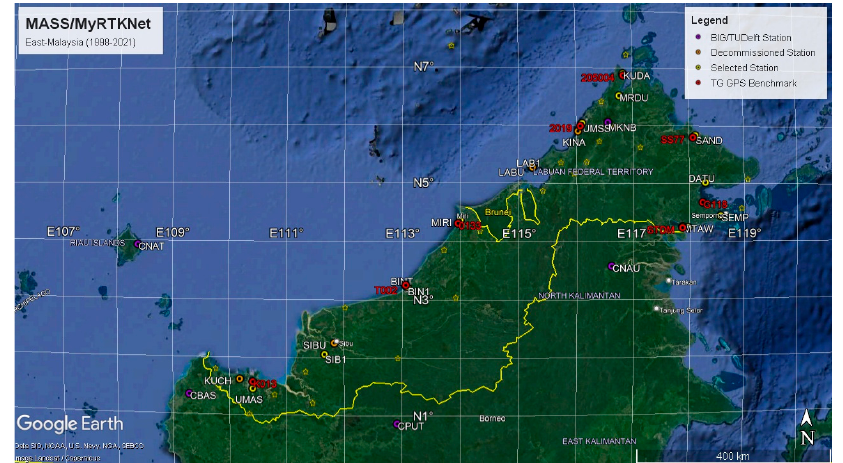
Figure 7. Location of 17 MASS/MyRTKNet and 1 GEODYSSA stations at 12 locations (of which 9 are near the tide gauges) in East Malaysia. Shown also are the 8 tide-gauge benchmarks (in red). Additionally, the 20+ other MyRTKNet stations (including 3 off-shore) currently operated by DSMM are shown (yellow open stars). The purple dots show the Indonesian InaCORS stations (CNAT, CBAS, CPUT, and CNAU) in the Indonesian part of Borneo (Kalimantan) as well as the TU Delft station MKNB on Mount Kinabalu in Sabah. Yellow indicates still active and orange discontinued stations. Image made with Google Earth Pro.